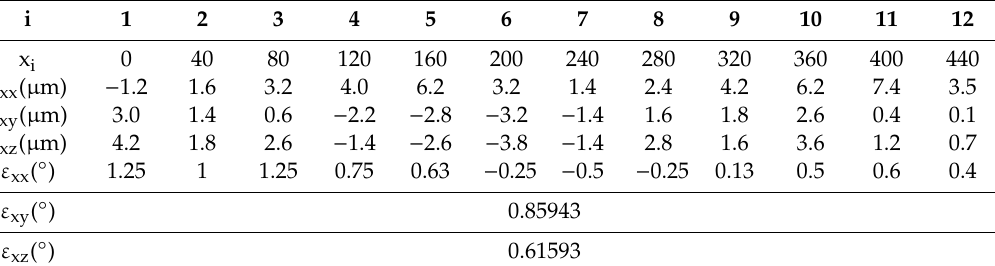
Table A1. Complete geometric errors of the X-axis.